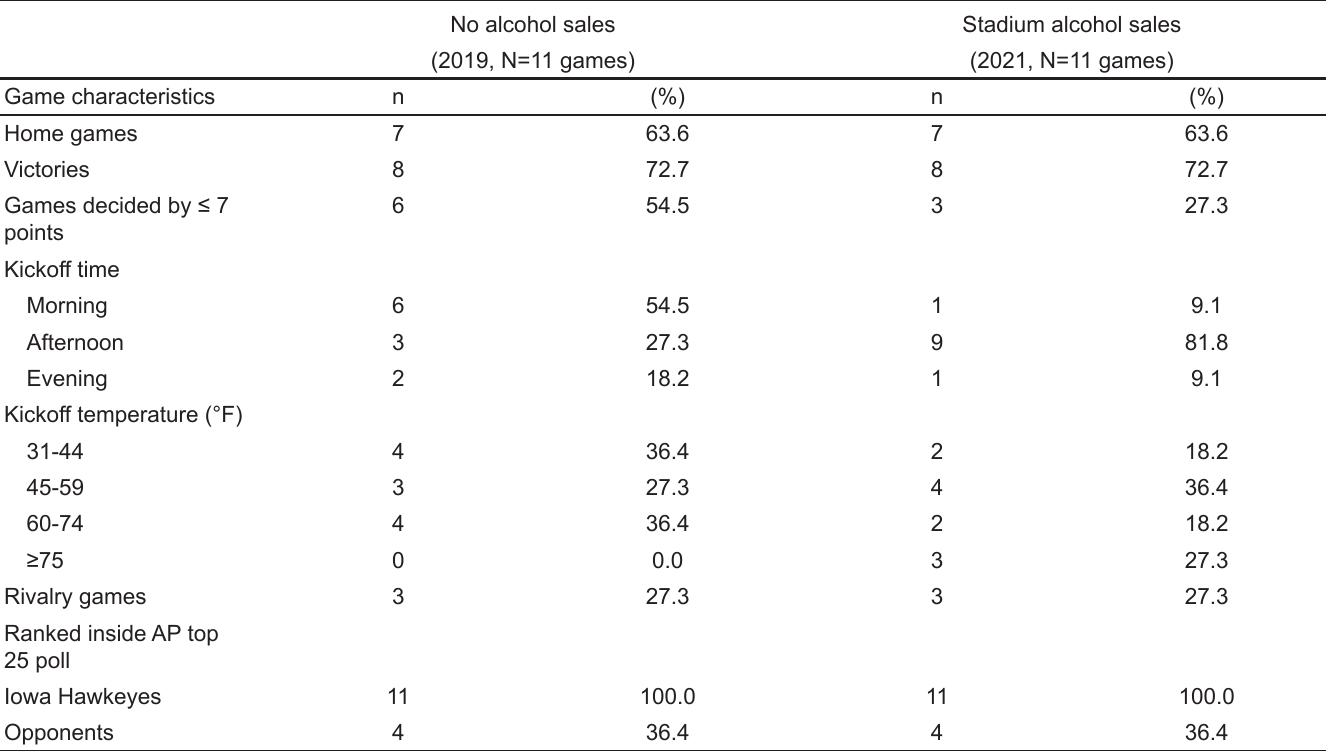
Table 1. Game day characteristics of the pre- and post-stadium alcohol sales periods, 2019 and 2021 football seasons at one Midwestern university.